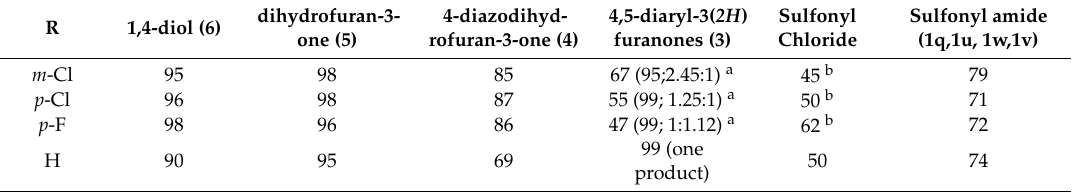
Table 3. Yields (%) of reactions on di ff erent steps of sulfonyl amide synthesis (Scheme 2).